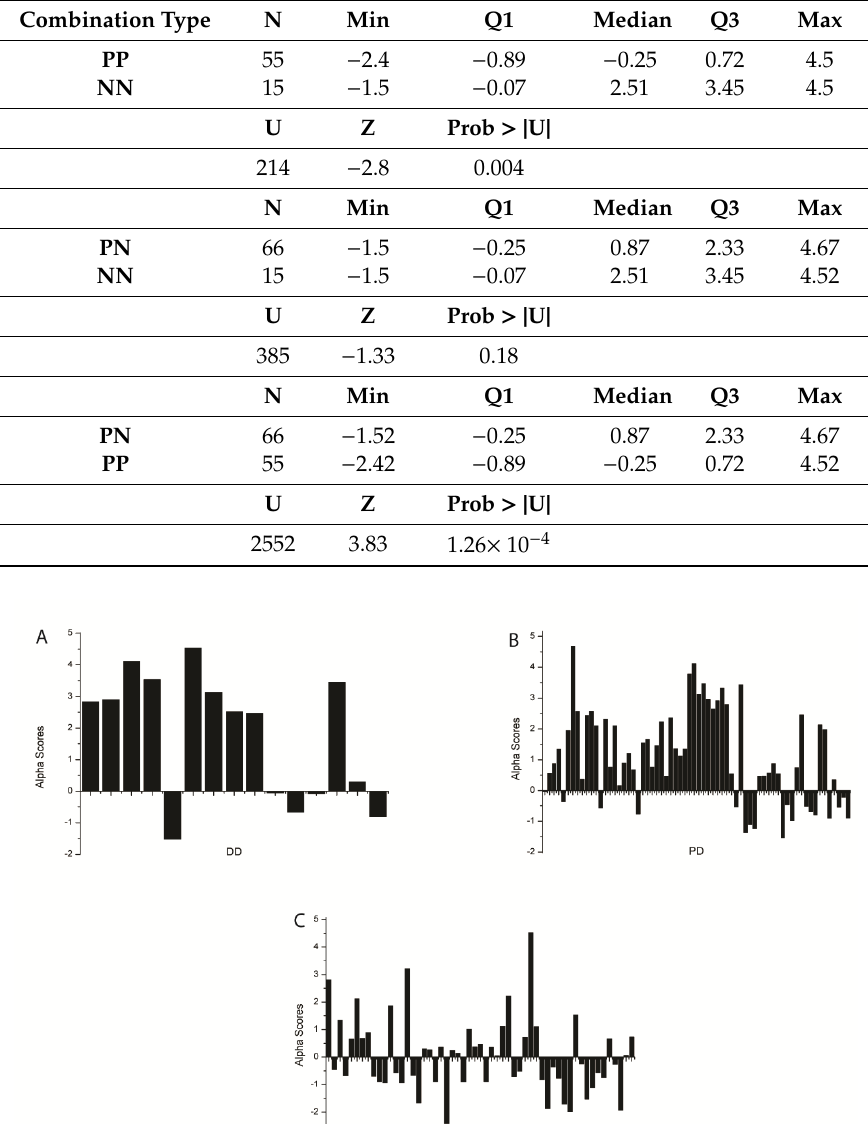
Table 2. Mann–Whitney U test for evaluation of alpha scores between di ff erent antibiotic groups. NN represents the pairwise combinations of nucleic acid synthesis mechanism-related antibiotics, PP represents the pairwise combinations of protein synthesis mechanism-related antibiotics, and PN represents the pairwise combinations of protein synthesis and nucleic acid synthesis mechanism-related antibiotics. Significance level is < 0.05.